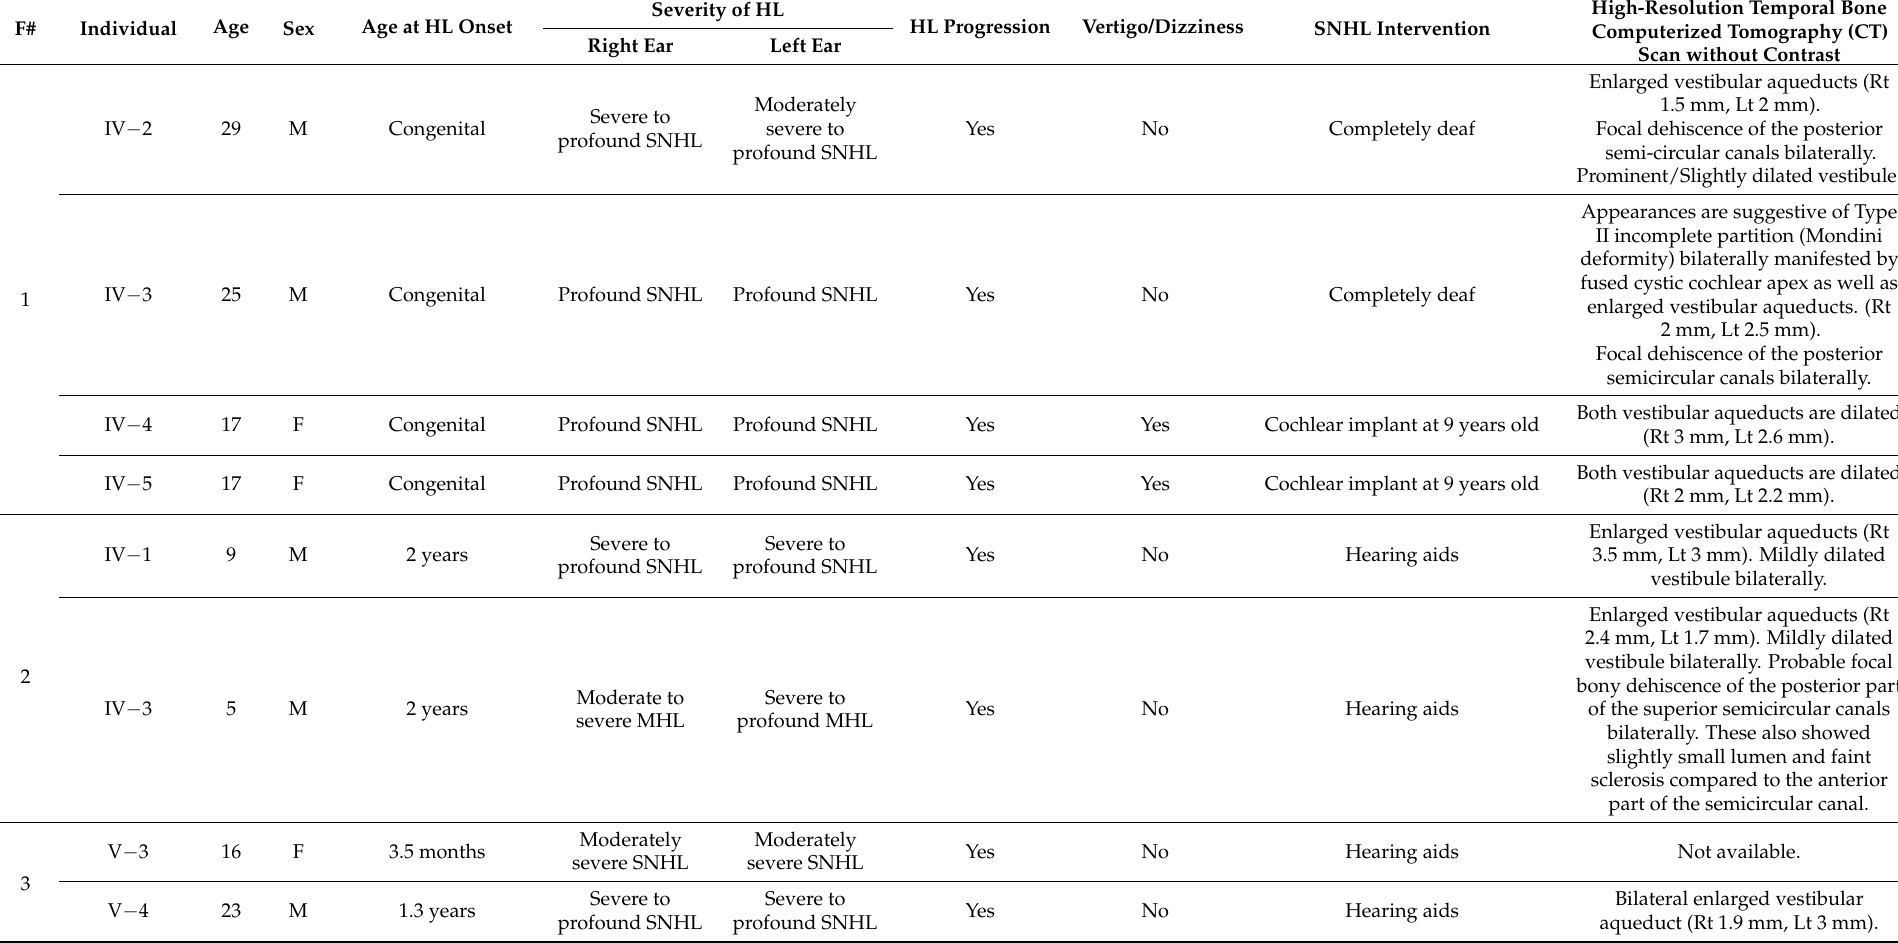
Table 1. Audiological findings and investigations of the affected